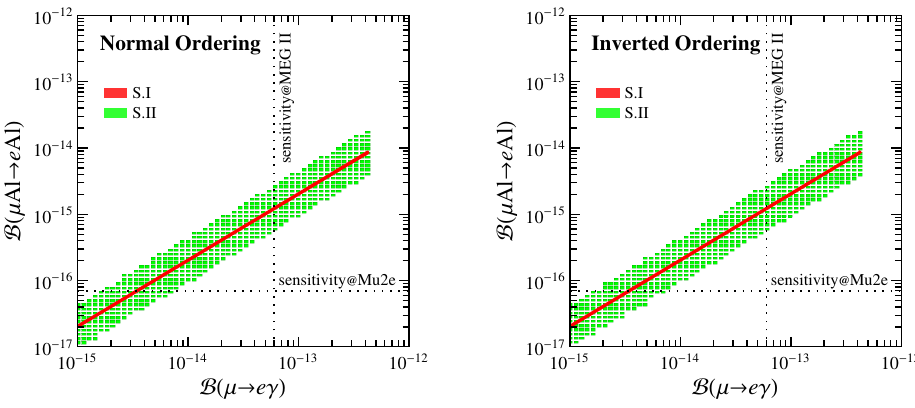
Figure 5 . Correlation between B ( (cid:22) ! e(cid:13) ) and B ( (cid:22) Au ! e Au), in the NO (left) and IO (right) cases. The red and black region denotes the S.I and S.II,